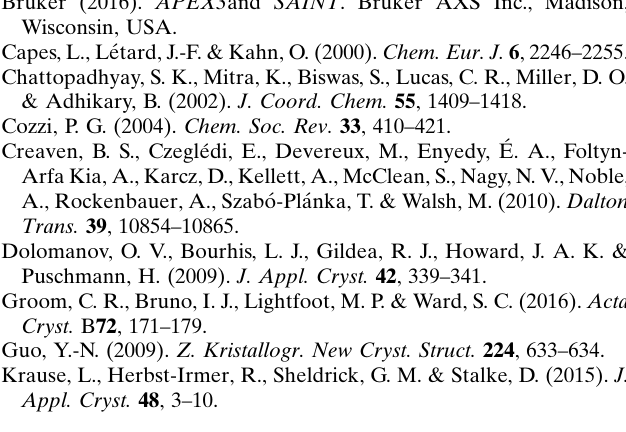
Crystal data Chemical